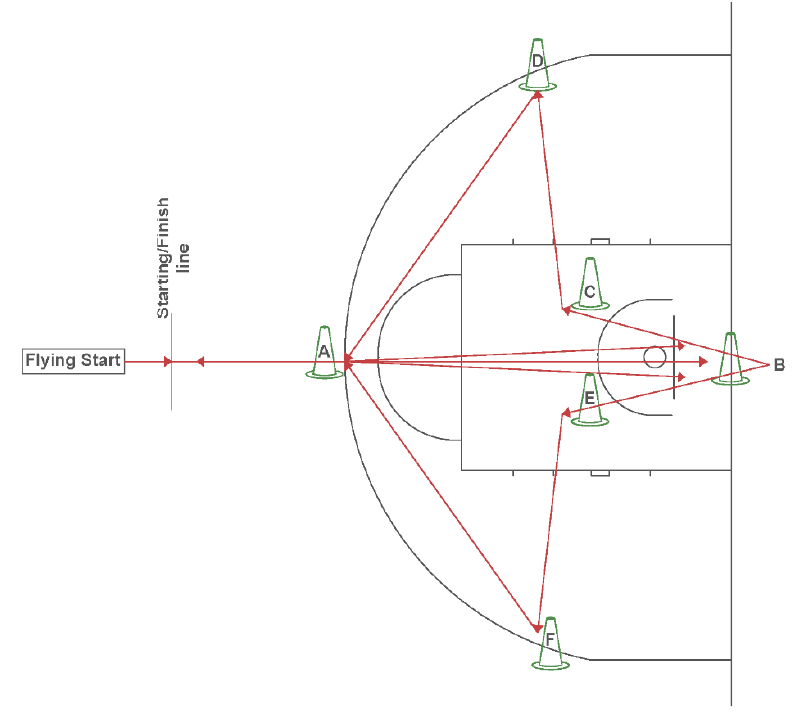
Figure 4. STARtest; adapted and edited from [31] .